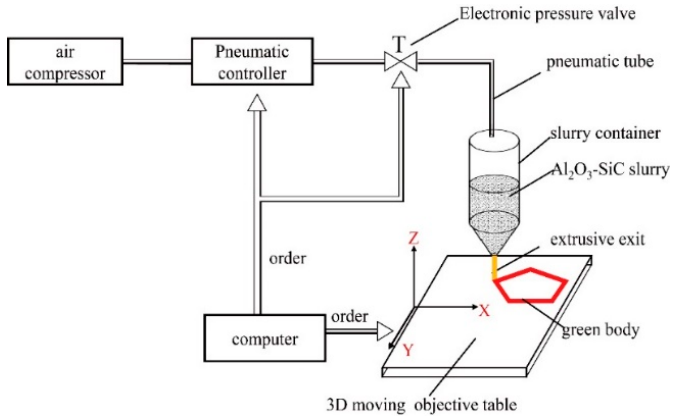
Figure 7. Schematic diagram of the 3D extrusion printing machine for fabricating Al 2 O 3 -SiC (3D) green bodies.